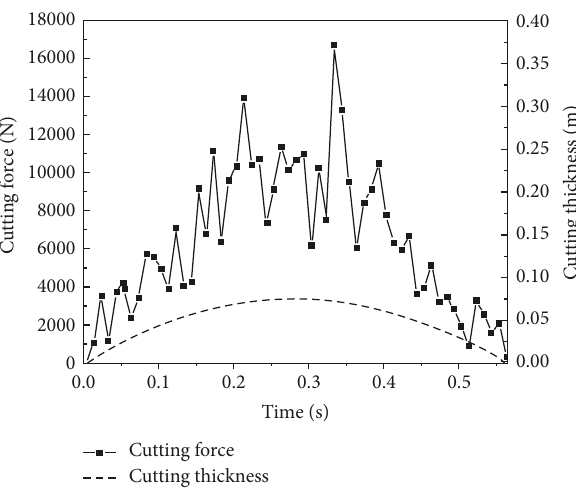
Figure 8: Cutting force of conical pick under the cutting parameter D .